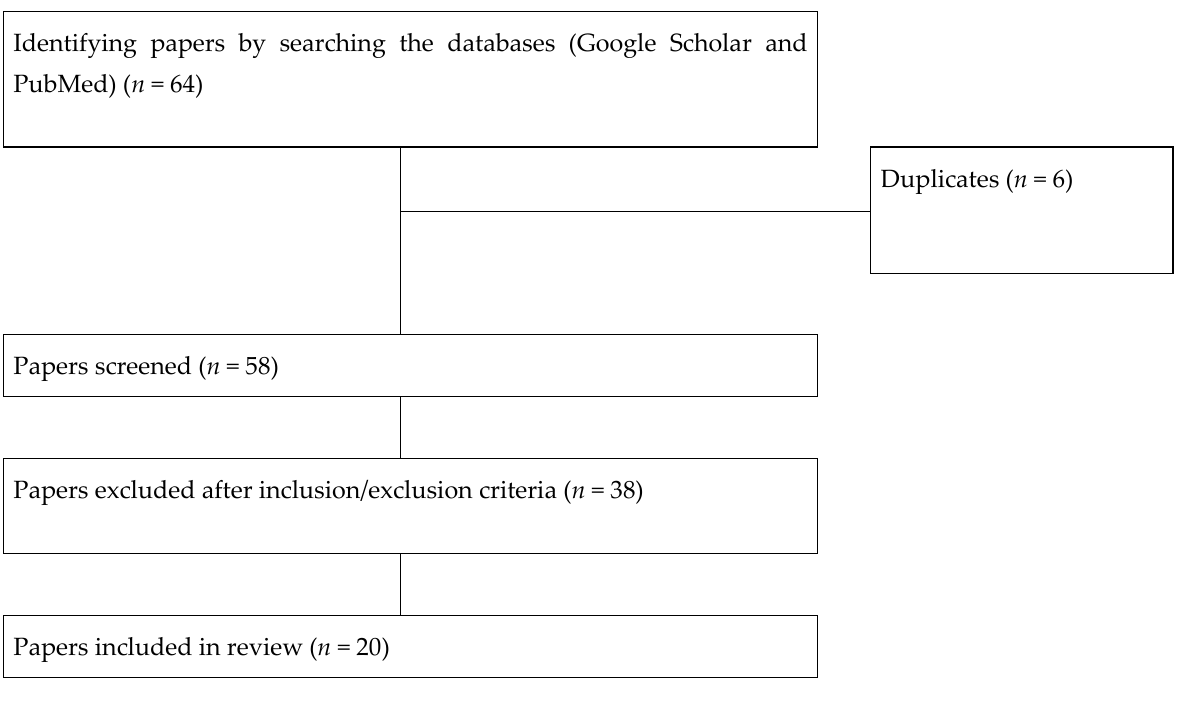
Figure 1. Flowchart overview of the results; how papers were retrieved, screened, and included.